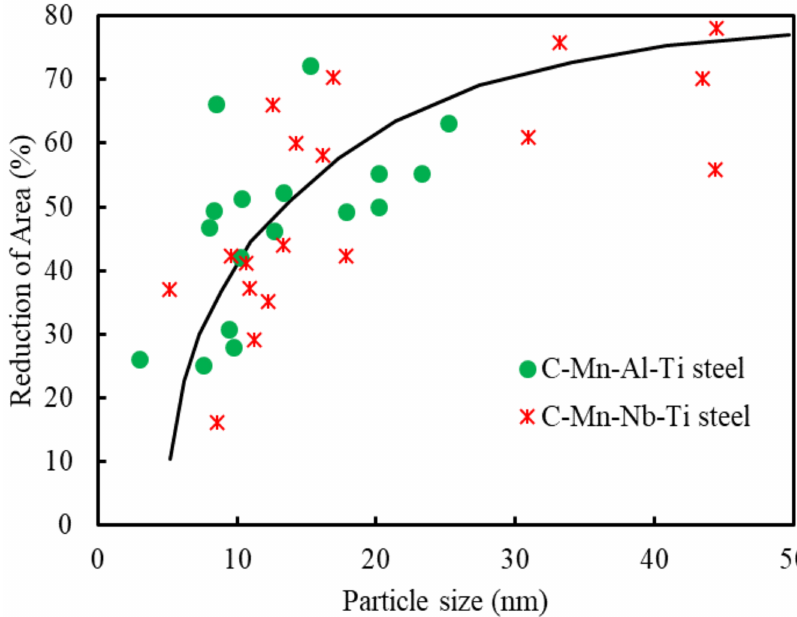
Figure 7. Influence of particle size on the RA value for C-Mn-Al-Ti and C-Mn-Nb-Al steels [19].